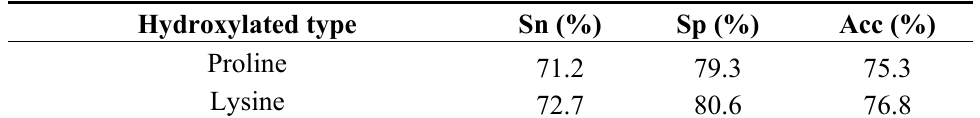
Table 3. The overall success rates in identifying hydroxylated sites for the proteins retrieved from the Swiss-Prot